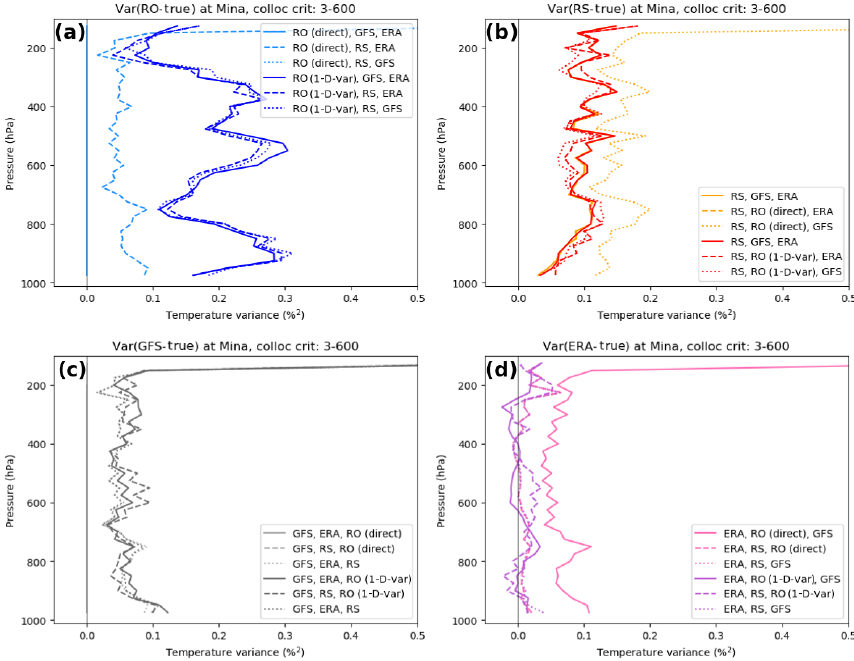
Figure 8. Estimated error variances (percent squared) of temperature at Mina: (a) RO, (b) RS, (c) GFS, and (d)